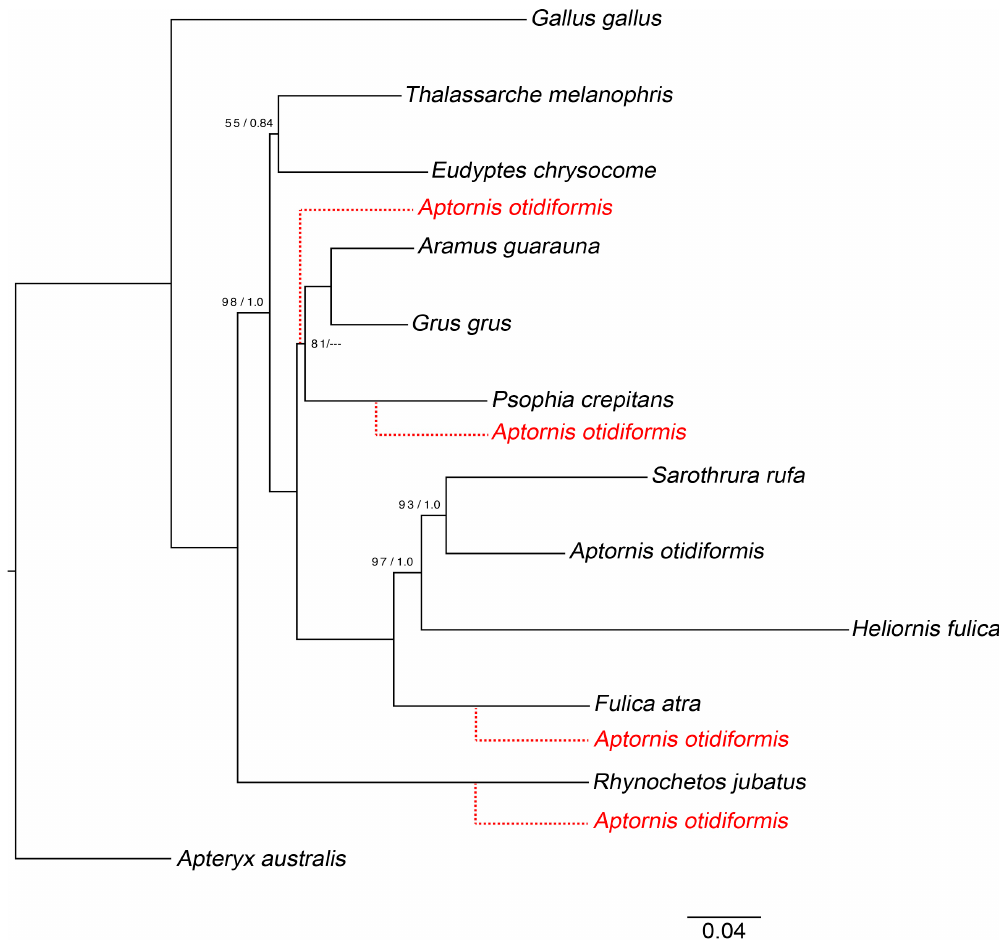
Figure 1. Maximum likelihood phylogeny from RAxML analysis of select mitochondrial sequences representing key higher-taxa. Branch lengths are scaled according to the number of substitutions. Values associated with branches are support values from our RAxML bootstrap analysis and posterior probabilities from a MrBayes analysis of the same dataset. Red dotted lines show alternative positions of Aptornis otidiformis that we tested with the Shimodaira–Hasegawa test (as implemented in RAxML) and were able to reject at p < 0.01. Node values correspond to maximum likelihood bootstrap (%)/Bayesian posterior probability.